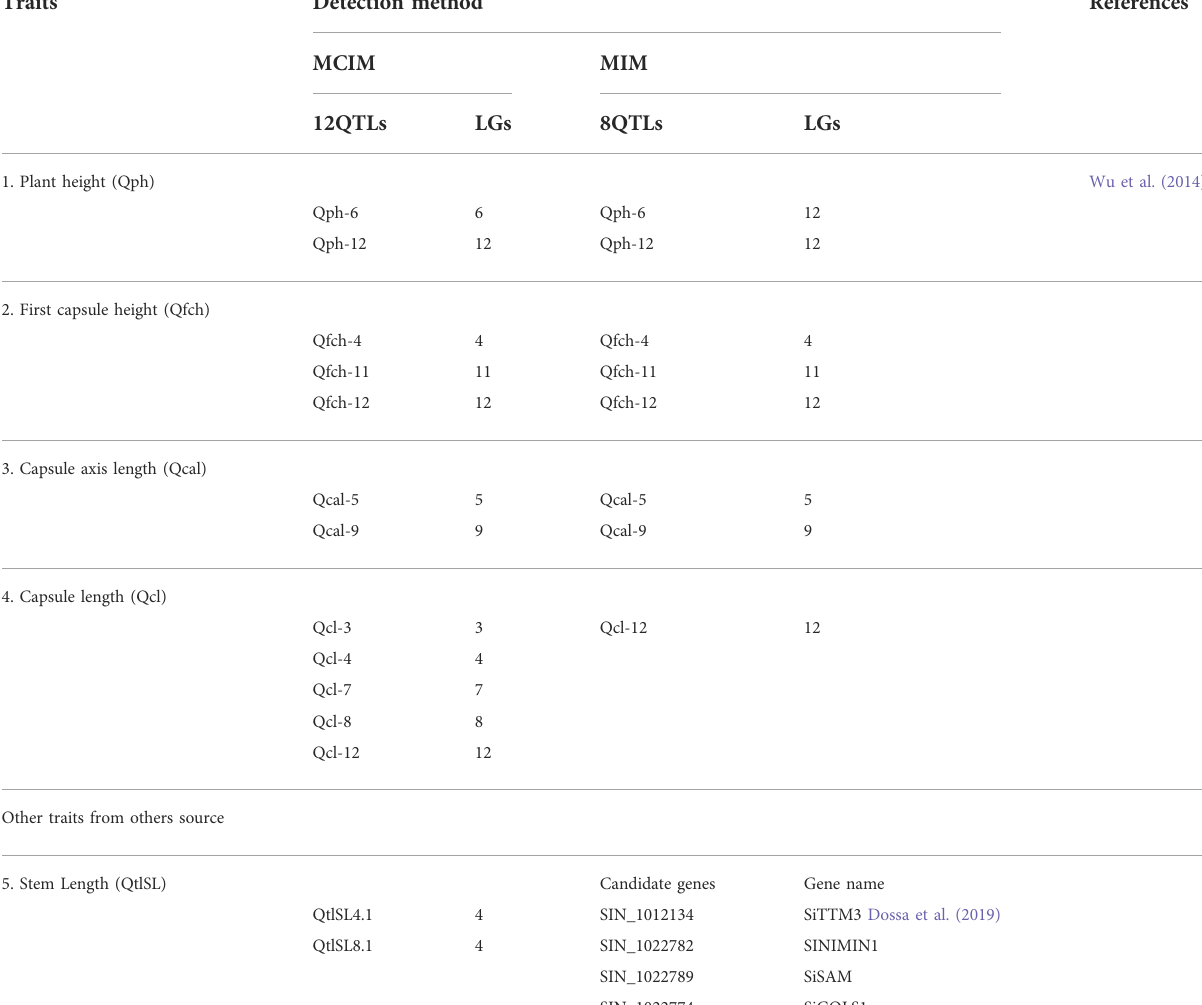
TABLE 3 QTLs and linkage groups (LGs) associated with sesame architecture traits.